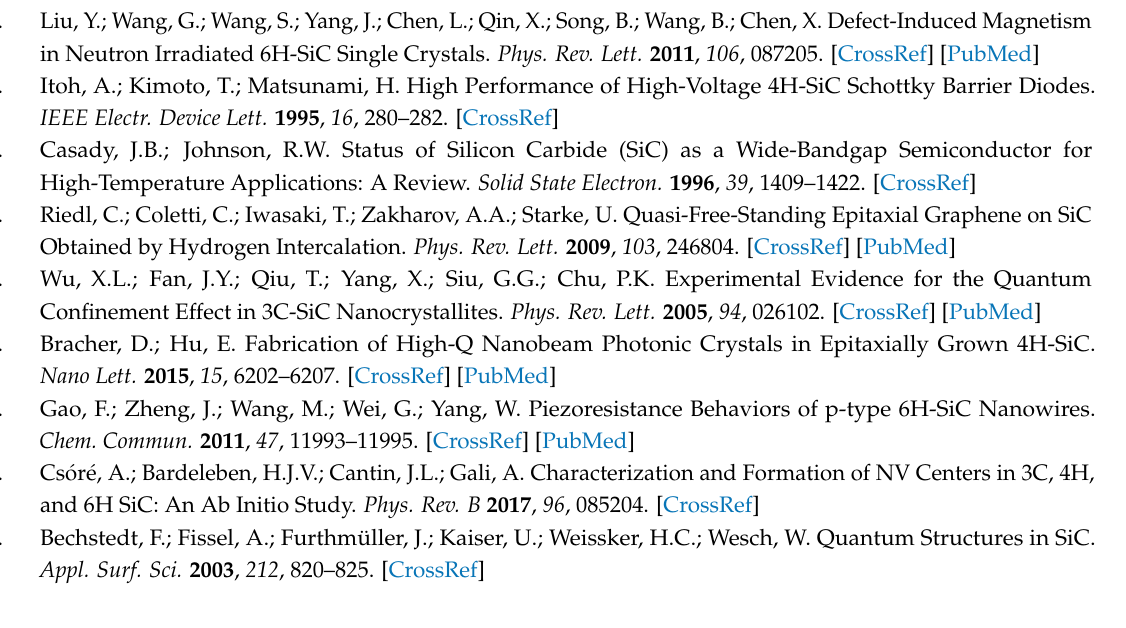
Supplementary Materials: The following are available online at http://www.mdpi.com/1420-3049/23/9/2296/s1, Calculation of Raman spectrum, Surface modification, Figure S1: Raman spectra of 6H-SiC with/without ethanol treatment, Figure S2–S7: Raman spectra and Lorenzian fitted